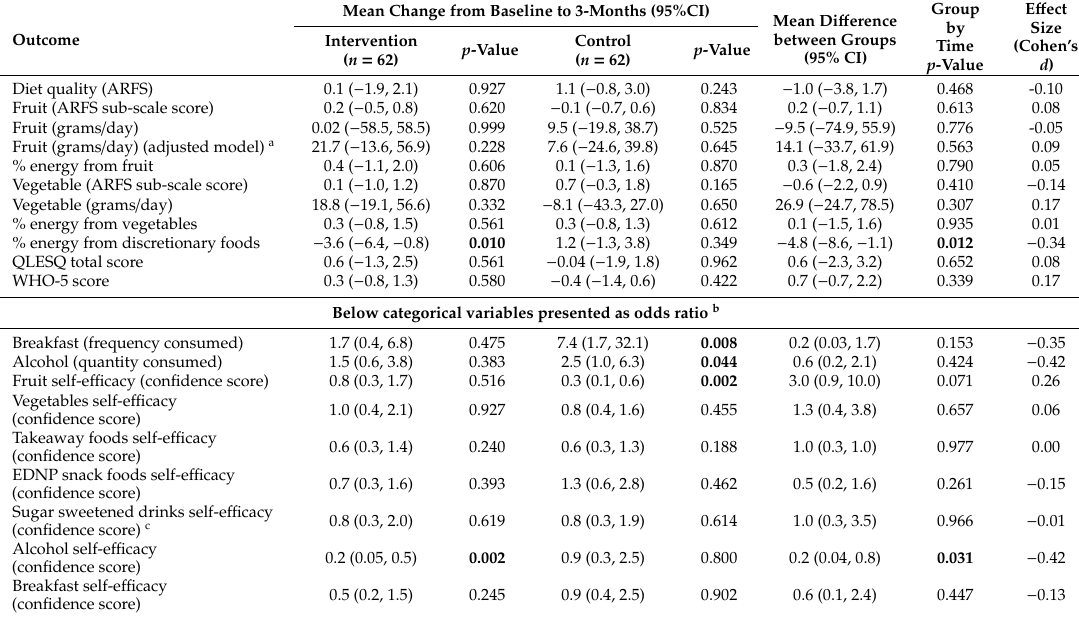
Table 3. Primary and secondary outcome changes in young adult university students (n = 124) participating in the Eating Advice To Students (EATS) brief web-based nutrition intervention pilot RCT from baseline to three months using intention-to-treat (ITT)